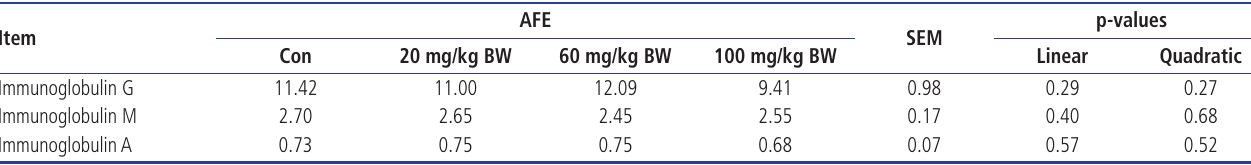
tions decreased (p = 0.03) linearly with increasing doses of AFE, supplementation tended to increase (p = 0.09) compared with whereas the proportion of neutrophil granulocytes increased (p controls. = 0.01) linearly. In addition, lymphocyte counts and proportions in control group was significantly higher (p<0.05) than that animals Effects of AFE on ruminal fermentation parameters and receiving 100 mg/kg BW AFE, and the proportion of neutrophil relative expression of microbial genes in dairy cows granulocytes showed the opposite result. The neutrophil granu- The valeric acid/TVFA ratio was increased (p = 0.01) linearly locyte count for the groups receiving 20 to 100 mg/kg BW AFE with increasing of the level of AFE supplementation. The ratio Table 6. Effects of AFE on immunoglobulin concentration (g/L) of dairy cows AFE p-values Item SEM Con Linear